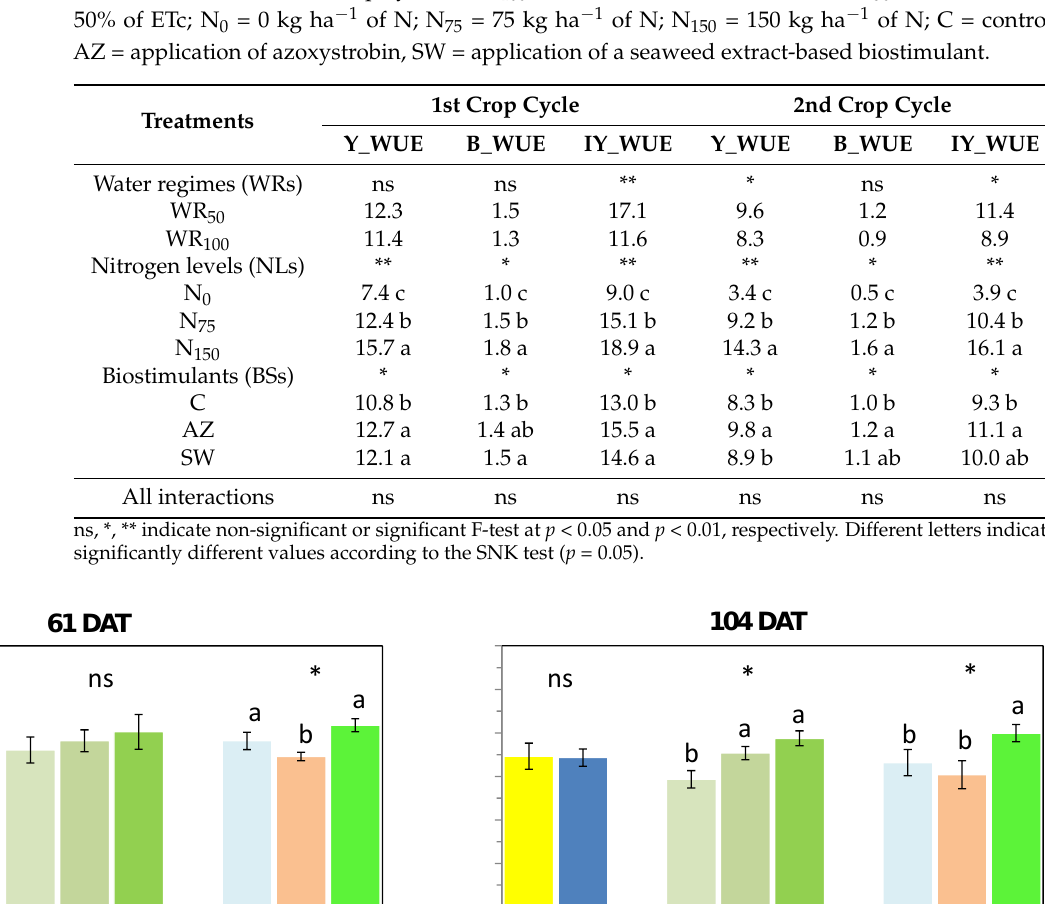
Table 4. Effect of water regimes, nitrogen levels, and the application of biostimulants on (i) water use efficiency in relation to marketable yield (Y_WUE, kg m −3 ) and above ground dry biomass (B_WUE, kg m −3 ) and (ii) irrigation water use efficiency in relation to marketable yield (IY_WUE, kg m −3 ) for wild rocket from two crop cycles. WR 100 = restoration of 100% of ETc; WR 50 = restoration of